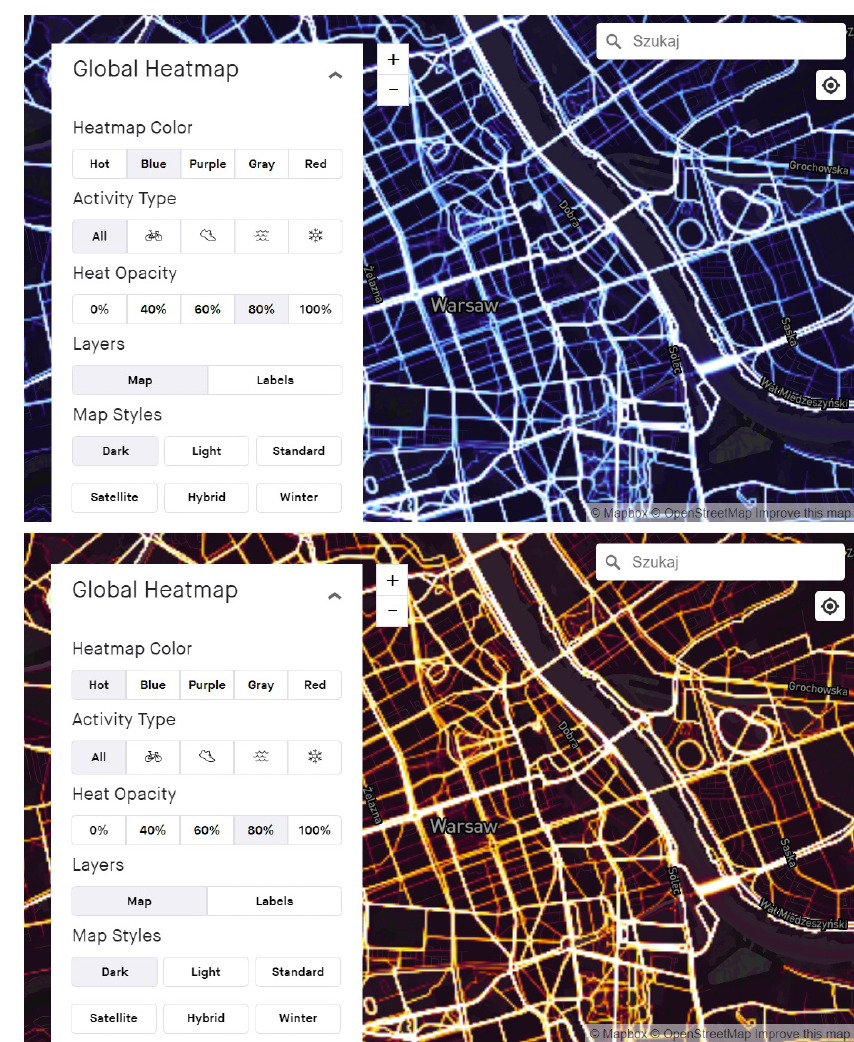
Fig. 3. Presentation of the density of routes of runners and cyclists along the streets in the Strava app in two color scales Hot and Blue (Strava, n.d., https://www.strava.com/heatmap#13.64/21.00488/52.23799/blue/all, access: